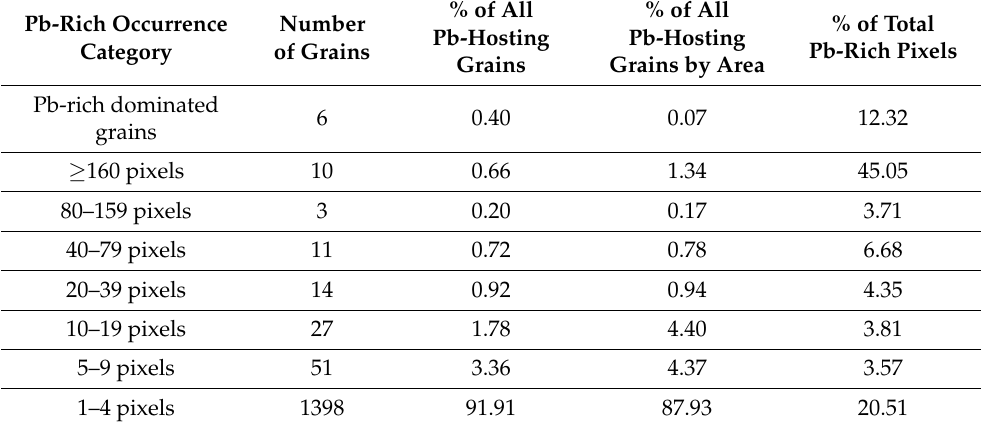
Table 4. Pb-occurrence categories and contributions to total Pb-rich pixels detected across all samples. See text in Section 3.3.1 for explanation of